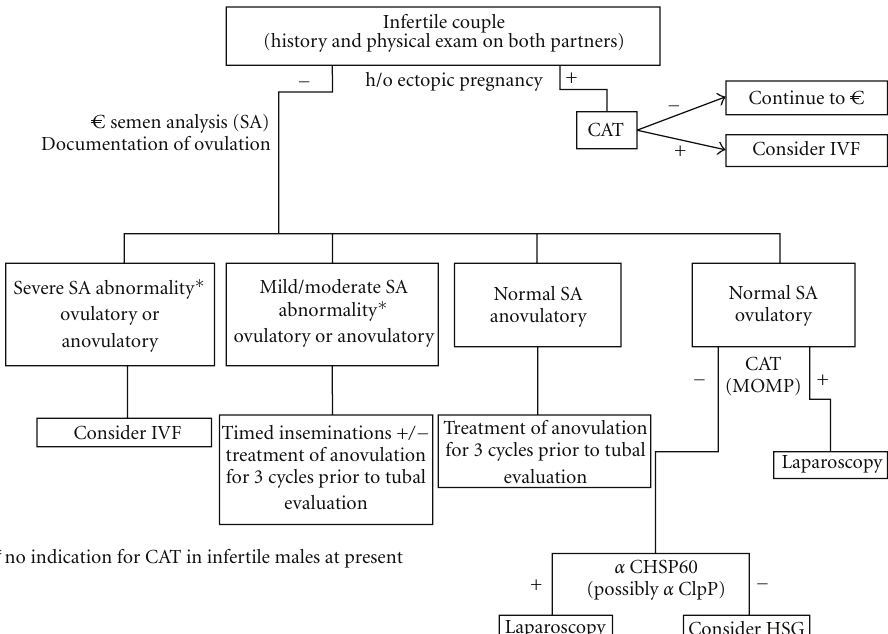
Figure 3: A proposed algorithm for use of chlamydial antibody screening in infertile